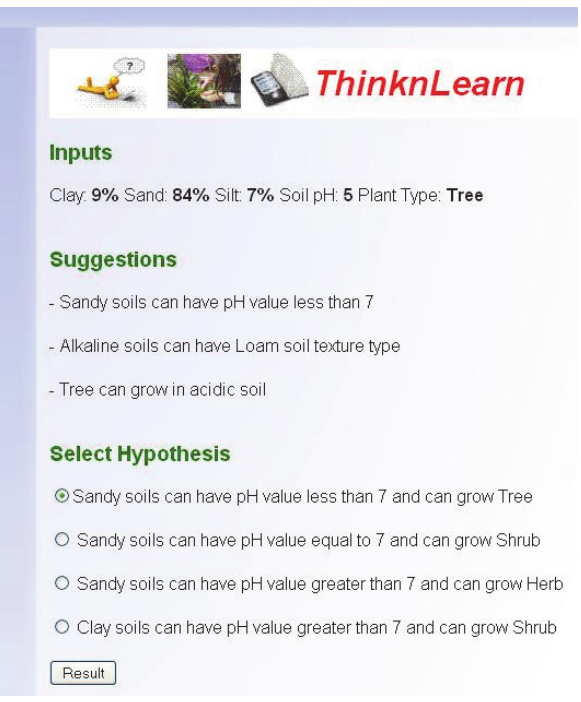
Figure 8 . Summary and hypothesis